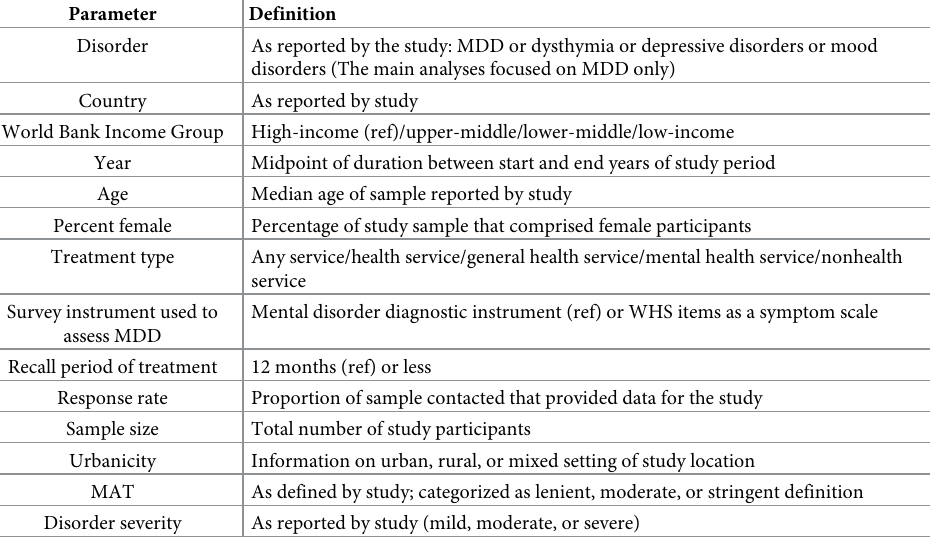
Table 2. List of parameters extracted and